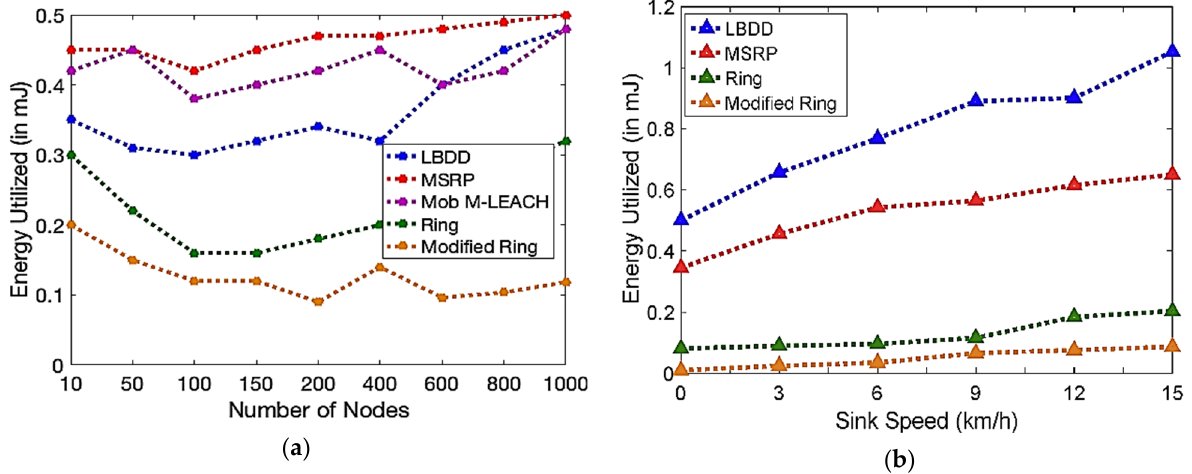
Figure 14. Energy consumption analysis; ( a ) variation in the network density; ( b ) variation in the sink speed.